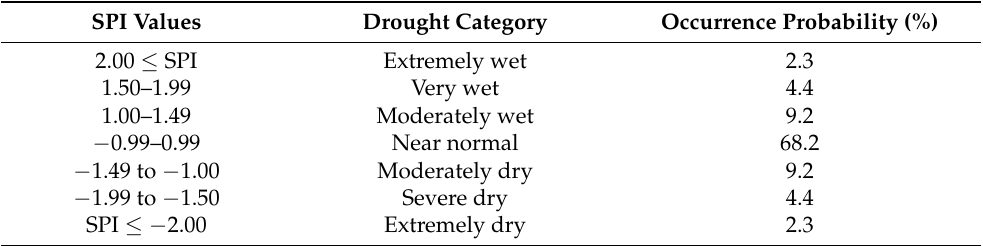
Table 1. Drought classification using SPI values and corresponding event probabilities. SPI Values Drought